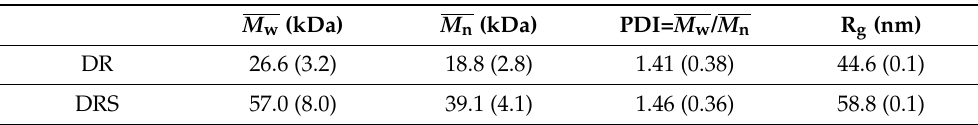
Figure 4. ( a ) Fractogram of molar mass of EPS-DR. The Light Scattering signal is plotted on the left Y axis, whereas the M w calculated from this LS signal using ASTRA is plotted on the right Y axis. ( b ) Debye plot measurements of light scattering intensity at ( θ ) angles 18°, 36°, 45°, 58°, 90°, 108°, and 135° and analyzed with ASTRA. Table 2. AF4-MALS characterization in terms of molar mass and dispersity. The values in the brackets correspond to the uncertainties.